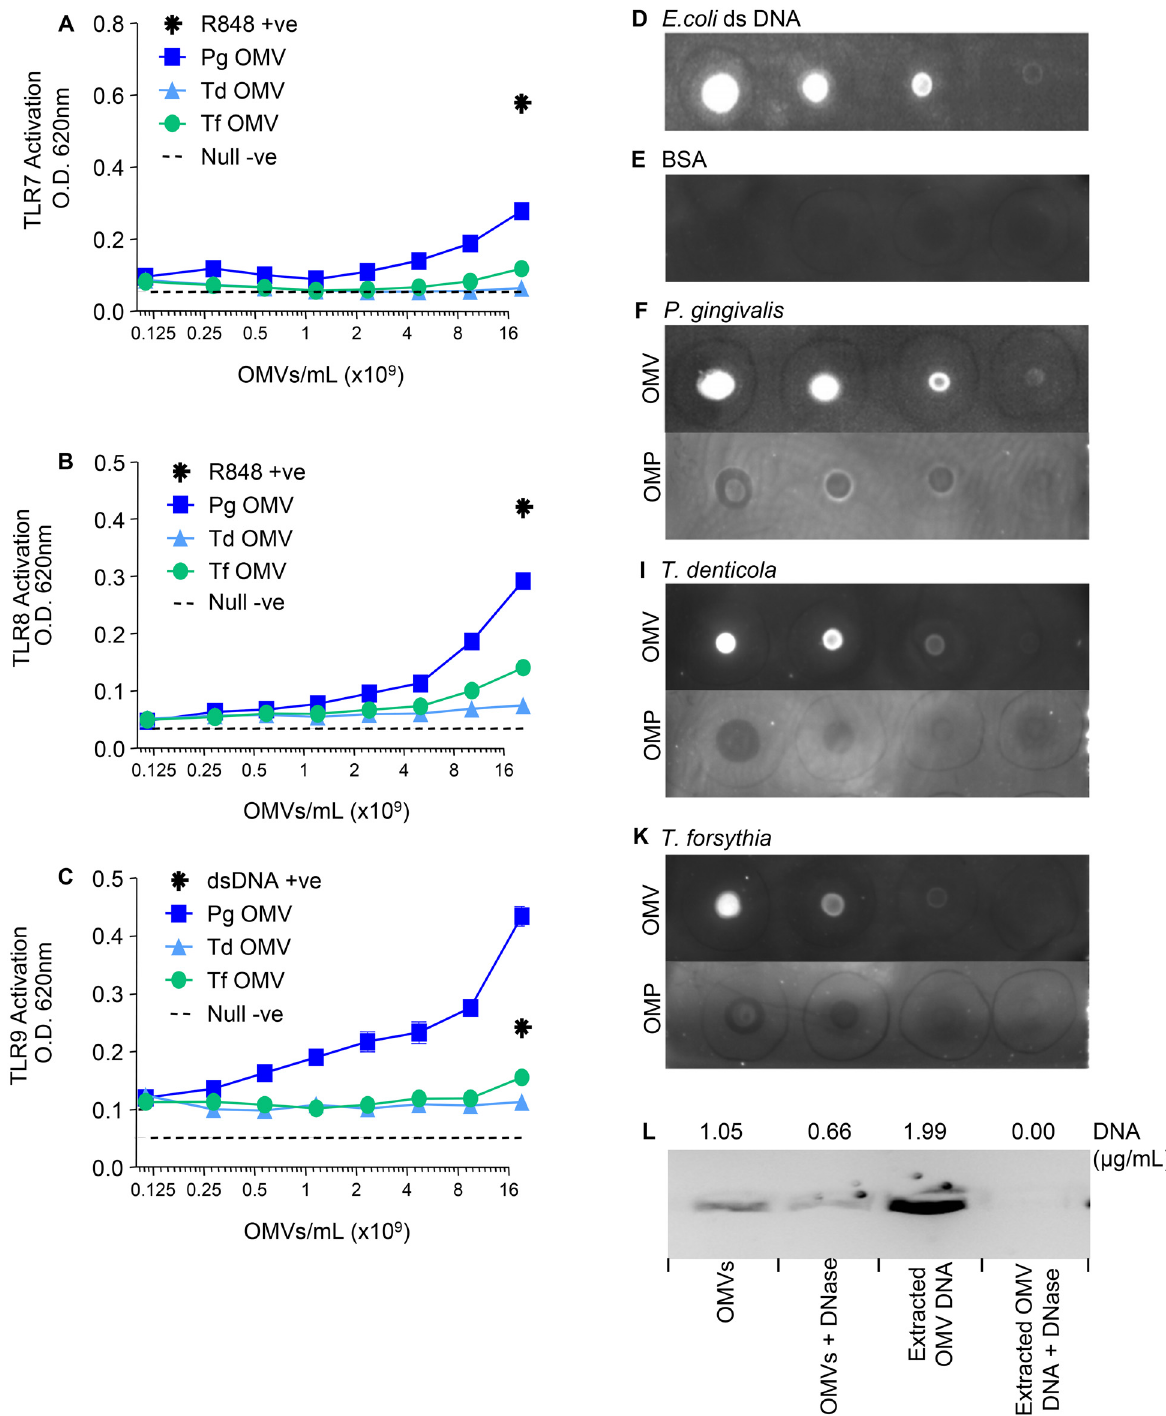
Fig 4. TLR7, TLR8 and TLR9 Activation by P . gingivalis , T . denticola and T . forsythia OMVs. HEK-Blue TLR7 (A), TLR8 (B) and TLR9 (C) Cell lines were challenged with 20 μ L of either purified OMVs or ligands R848 (10 μ g/mL in 2 fold dilutions) and dsDNA (100 μ g/mL in 2 fold dilutions) respectively. Alkaline phosphatase secretion was determined after 20 hours incubation at 620nm on a spectrophotometer. Monoclonal antibody α dsDNA MAB030 was used to detect DNA in purified OMV preparations and Triton X-114 extracted Outer Membrane Protein (OMP) preparations, used at 0.5 mg/mL protein and 1.5 mg/mL protein respectively, for P . gingivalis (F), T . denticola (I) and T . forsythia (K). OMV preparations were spotted on a nitrocellulose Immuno-Blot PVDF Membrane for Protein Blotting in three 10-fold dilutions. E . coli double stranded DNA was used as a positive control at 50 ng/mL in three